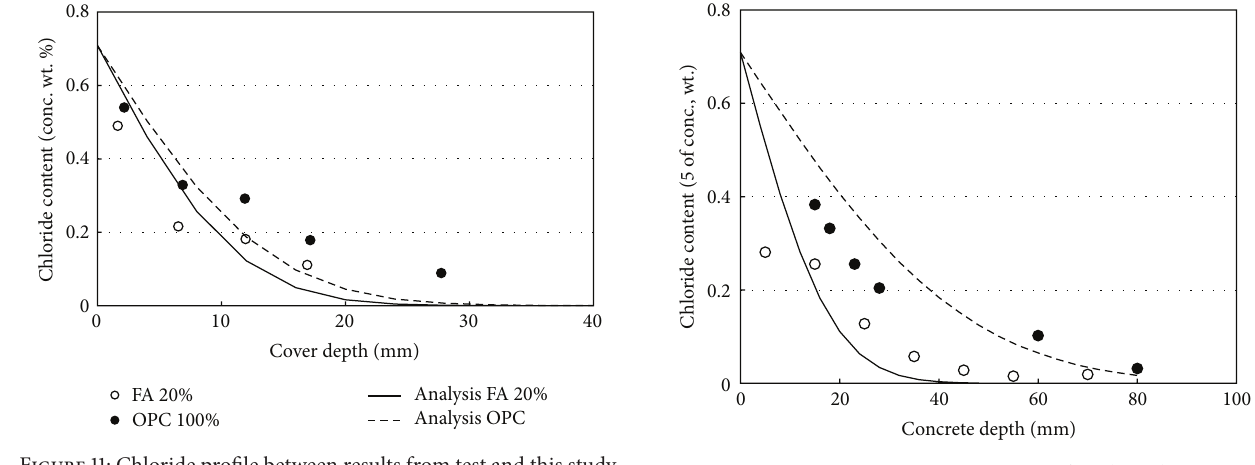
more extended mix proportions and the related diffu- sion coefficients, this technique can be modified and more applicable to evaluation of chloride